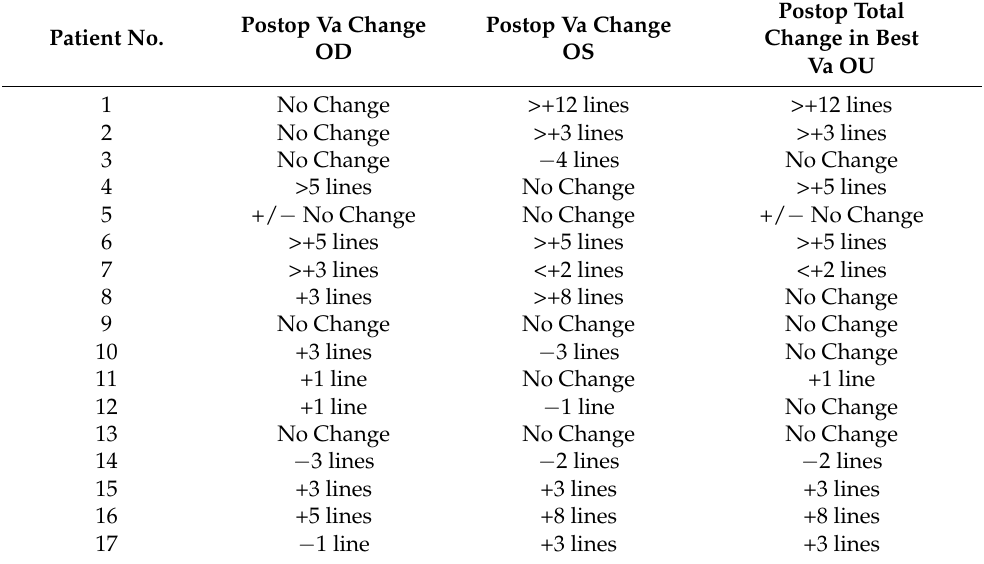
Table 3. Lines of vision